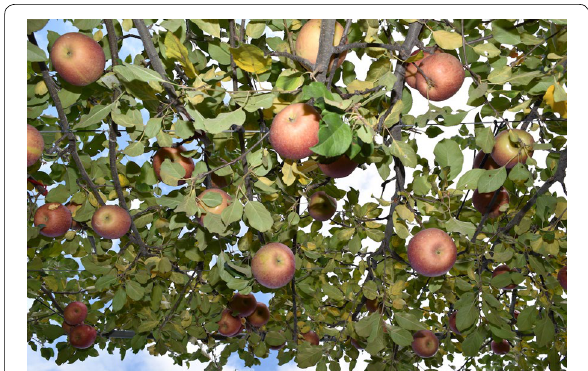
Fig. 6 Example of test image1